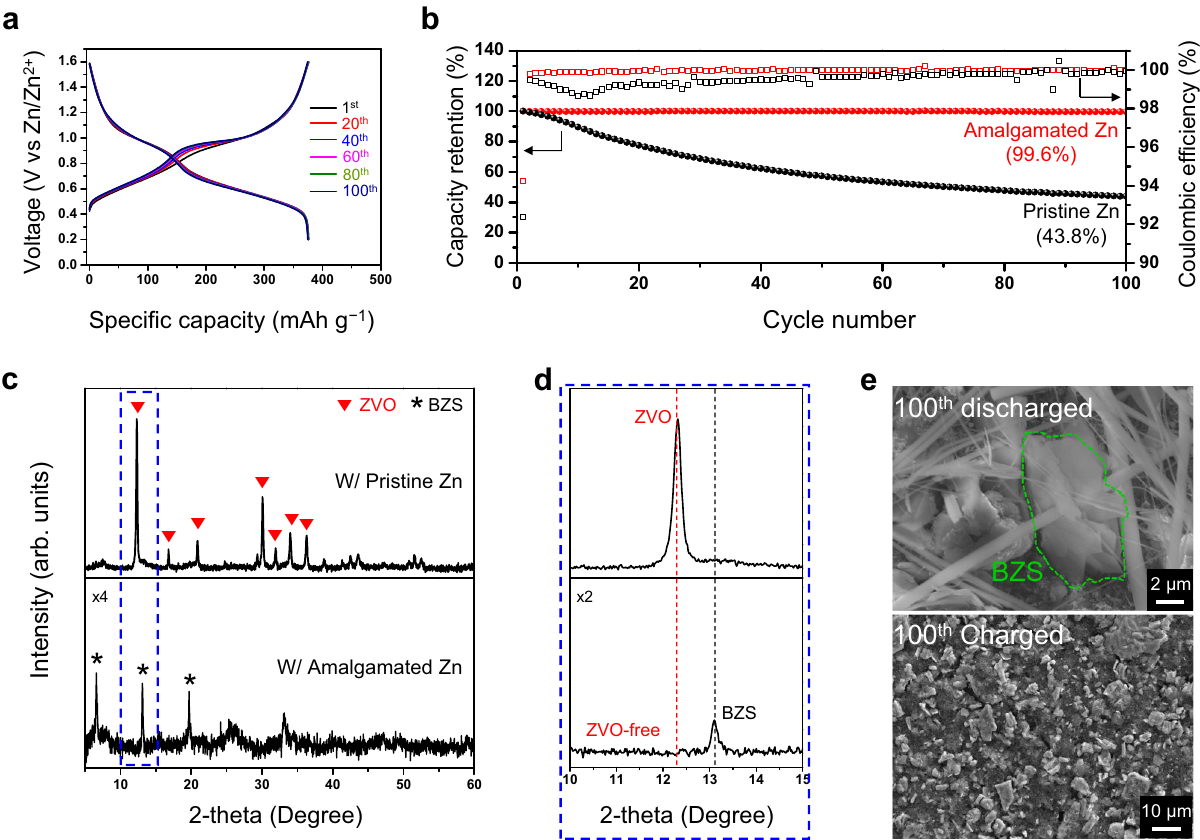
Fig. 6 The in fl uence of the non-corrosive Zn anode on the degradation of VOX electrode. a Galvanostatic charge-discharge pro fi les of VOX electrode at different cycle numbers when cycled at 200 mA g − 1 with amalgamated zinc metal. b Cycling performance of VOX electrodes with pristine zinc metal and amalgamated zinc metal at 200 mA g − 1 . c Ex-situ XRD patterns of discharged VOX electrodes after 100 cycles when paired with pristine Zn metal and amalgamated Zn metal. d Magni fi ed view of ( c ) in the 2 θ range from 10°~15°. e SEM images of VOX electrodes at the 100 th cycle when paired with amalgamated zinc metal